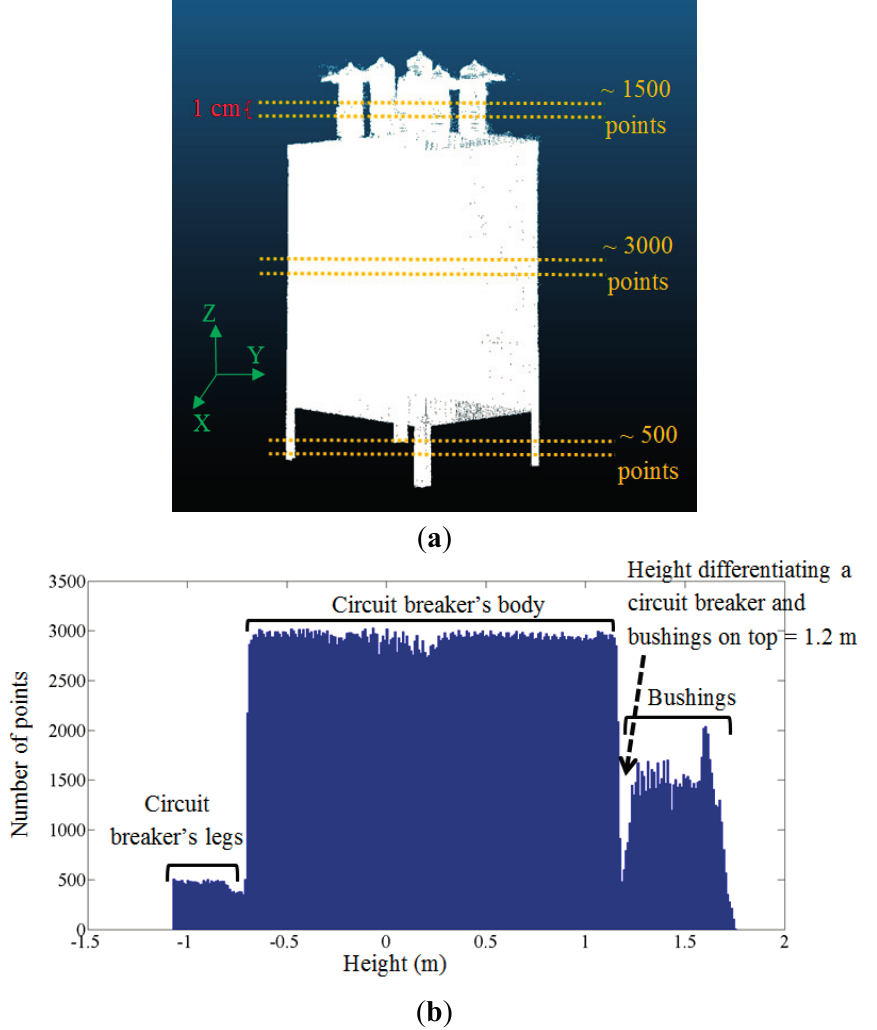
Figure 11. A segment containing a circuit breaker topped with six bushings is divided to slices in vertical direction ( a ). Histogram of slices’ points number ( b